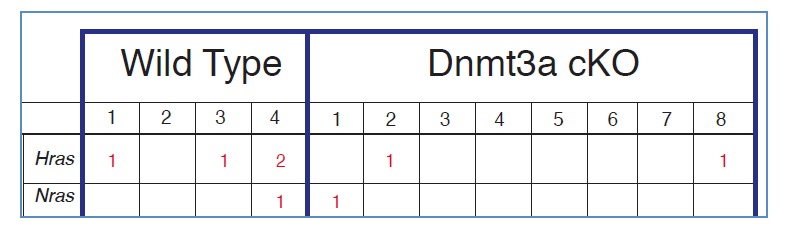
DOI:
http://dx.doi.org/10.7554/eLife.21697.038